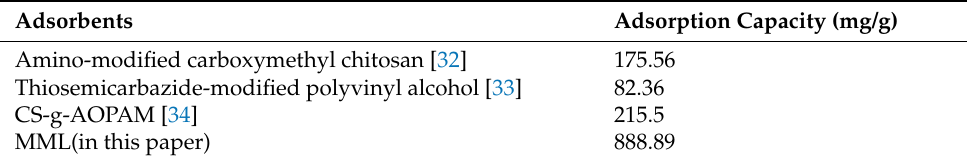
Table 3. Adsorption capacity of several modified natural polymers for Cu(II) ions.